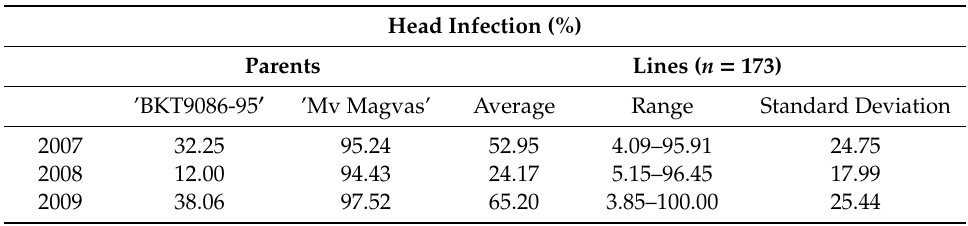
Table 1. Annual average infection of lines and parental genotypes under greenhouse conditions ( n = 175, Martonv á s á r, 2007–2009).